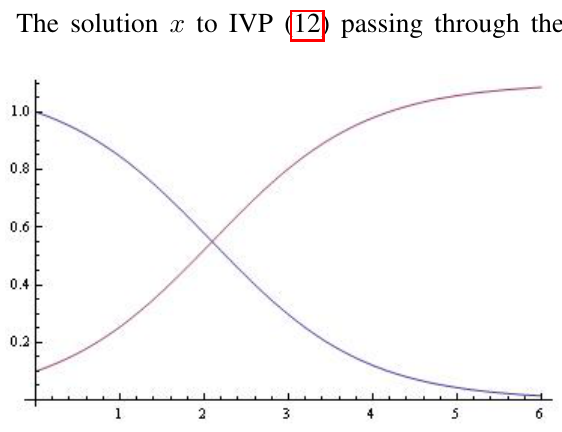
Fig. 2. Solutions to (11) with u (0) = u ∗ = 1 . 0 , x (0) = x ∗ = 0 . 1 . .